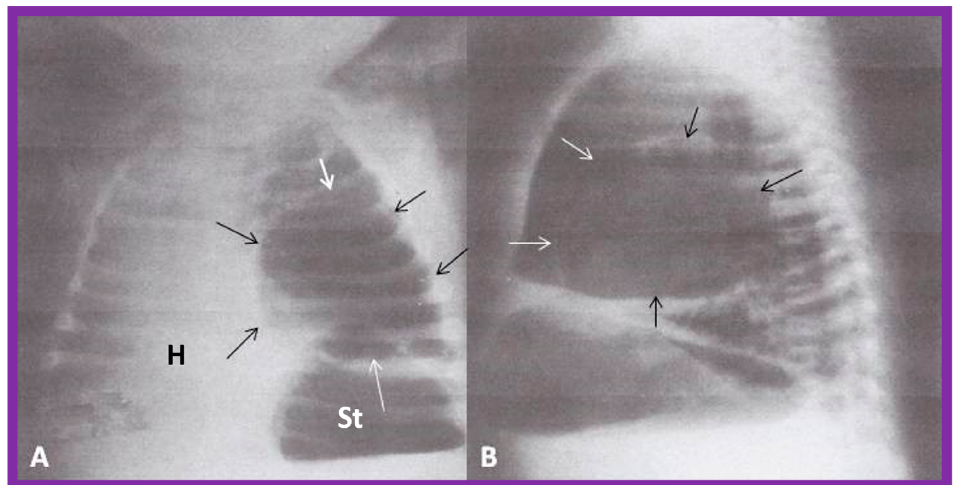
Figure 14. Chest film in posteroanterior ( A ) and lateral ( B ) projections demonstrate a large pulmonary cyst, shown with arrows. As one can see, the heart (H) is pushed to the right, i.e., dextroposition of the heart. St, stomach bubble. Reproduced from reference [22].